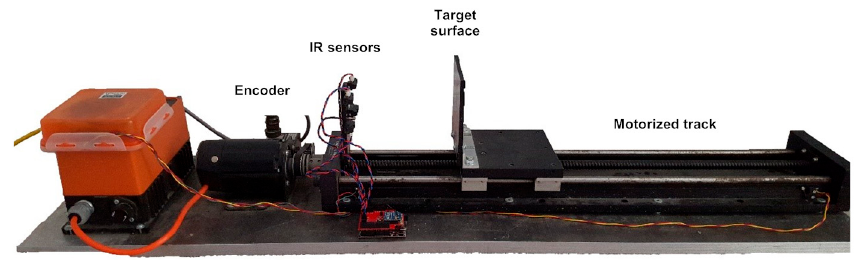
Figure 11. Embedded range sensors calibration procedure.